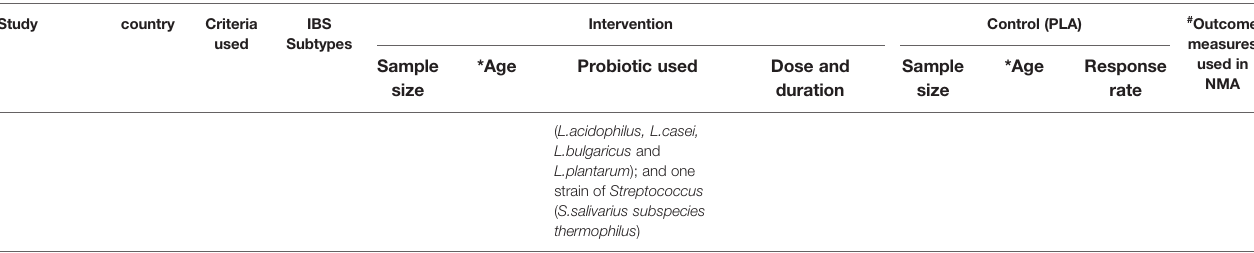
Figure 2A . The results of the global and local inconsistency tests are presented in Figure S2 and Table S1 . Both tests showed that there was no signi fi cant inconsistency between the direct comparisons and indirect comparisons; thus, the consistency model was used. The NMA revealed that B. coagulans (OR 60.73, 95% CI, 14.83 to 248.61), L. plantarum (OR 15.62, 95% CI 2.90 to 84.21), and L. acidophilus (OR 3.00, 95% CI 1.03 to 8.68) had a greater effect on symptom relief rate in patients with IBS compared with placebo (PLA). The SUCRA analysis ( Table S2 and Figure S3 ) and league table ( Table 2 ) showed that B.